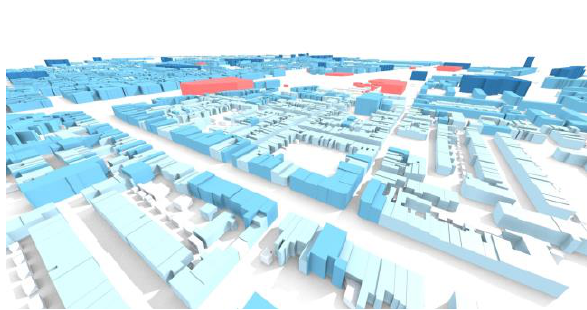
Figure 2. Visualisation of the generated 3D BAG data. Blue represents different height classes. The point heights for the red buildings are not representative, because the buildings are newer than the points (in this case, old buildings have been replaced by new